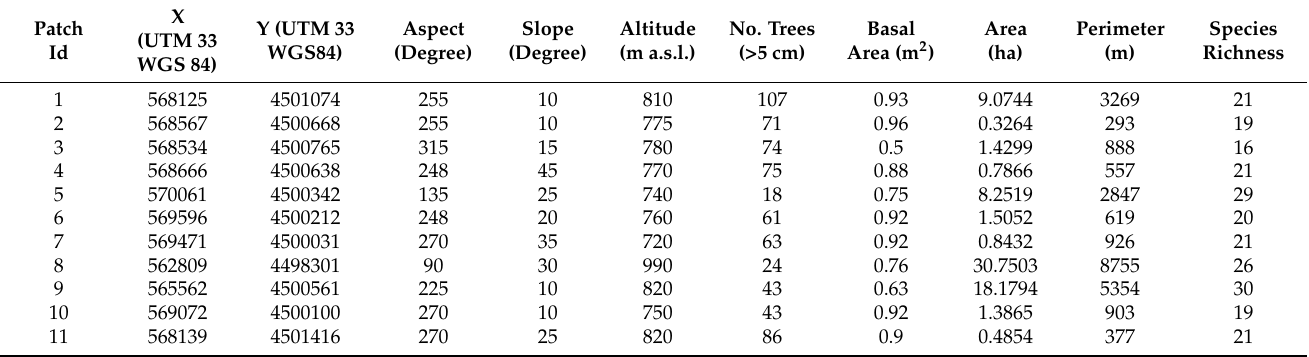
Table 1. Coordinates of sampling plots with environmental variables, forest structure parameters, and landscape variables of each sampled woody patch. Patch IDs correspond to those in Figure